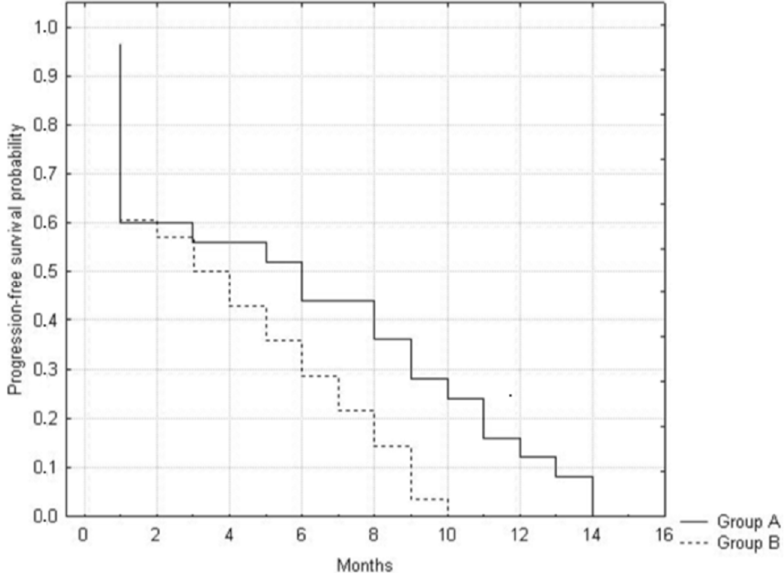
Figure 3. Kaplan–Meier progression-free survival analysis and log-rank test were performed to evaluate PFS in the two groups. p < 0.05 was considered significant.